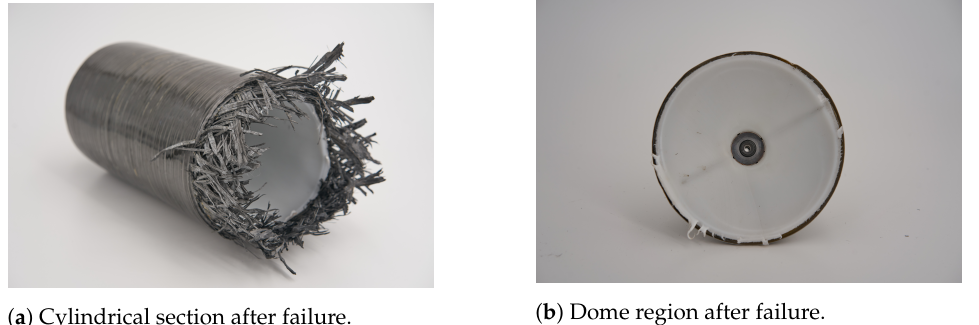
Figure 15. Sectional view of a dome-cylinder interface showing the thickness jump due to the hoop and polar winding.